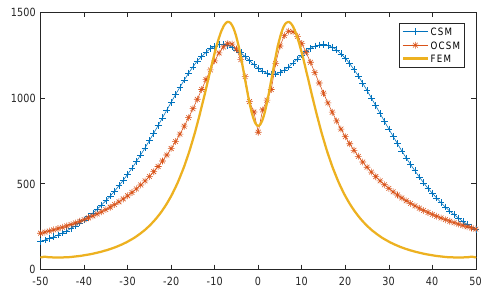
Figure 15. Electric field intensity of CSM, OCSM, and FEM at observation plane Y = 100 m, Z = 2